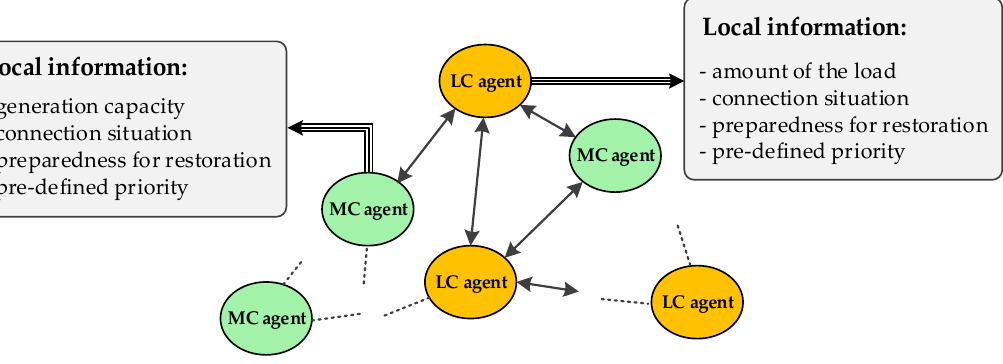
Figure 7. Conceptual decentralized multi-agent based model for MG restoration.